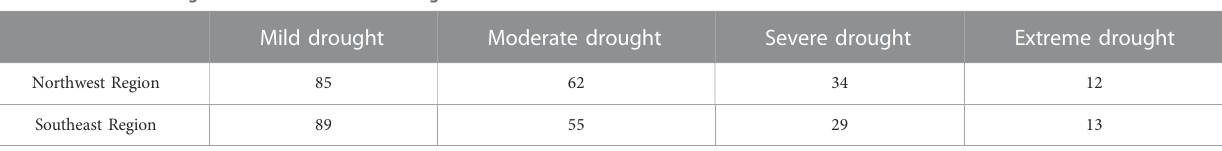
TABLE 1 Numbers of drought occurrences in different regions. Mild drought Moderate